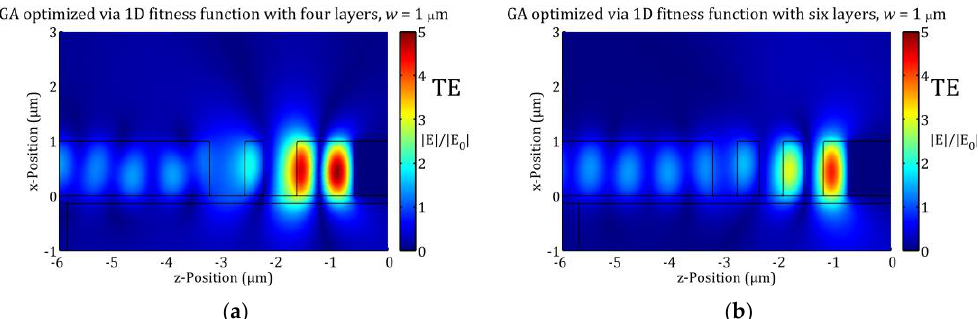
Figure 5. Resonance profile showing the relative field enhancement | E | / | E 0 | ( E 0 denotes electric field without TP structure) for ( a ) four layers (two etched air gaps) and ( b ) six layers (three etched air gaps) for TE polarization and w = 1 µ m. The fields correspond to thickness configuration obtained via GA optimization featuring 1D TP structures (see Table 1). The higher electric field in panel ( a ) leads to a higher absorptance by silver of 75%, whereas in panel ( b ) the field corresponds to an absorptance of only 60%.